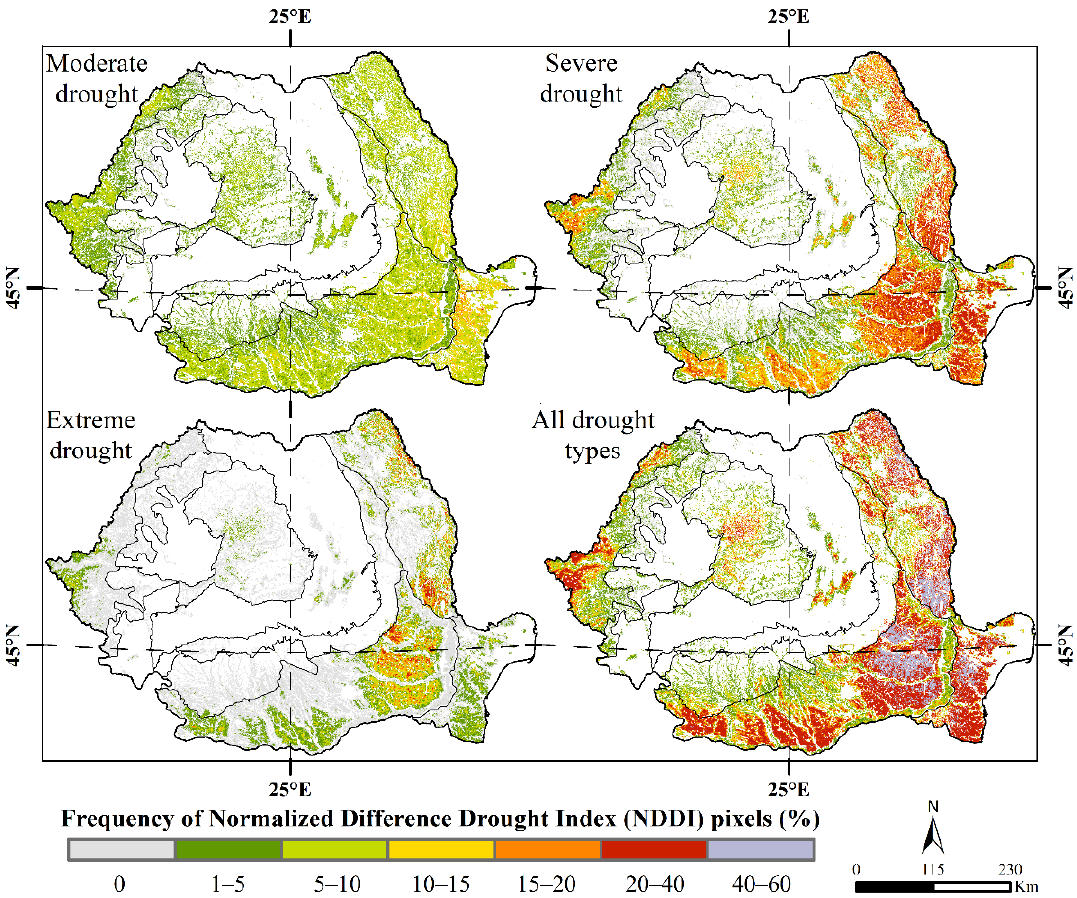
Figure 6. Spatial relative frequency of drought classes at the level of arable lands in Romania between 2001 and 2020.